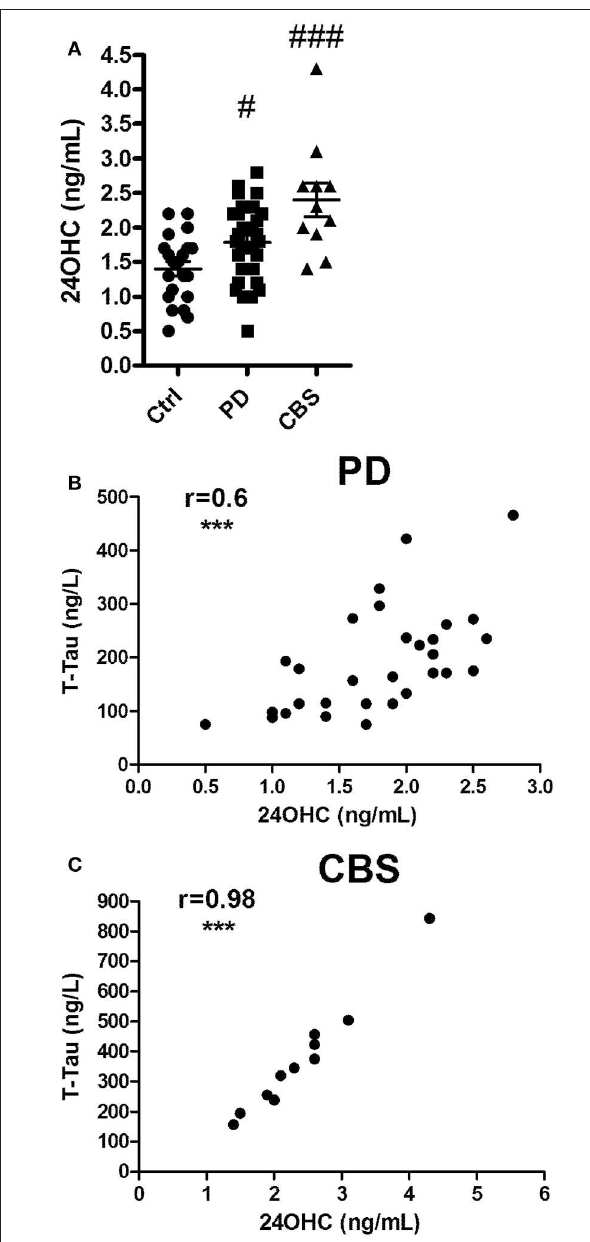
FIGURE 1 | (A) Levels of 24OHC in CSF from controls or patients with Parkinson’s disease (PD) or Corticobasal syndrome (CBS). (B,C) Correlations between CSF levels of 24OHC and total Tau in PD (B) and CBS (C) patients. In (A) , # p < 0.05, ### p < 0.001 vs. control. In B,C , r values indicate Pearson correlations and *** p < 0.001 significance.